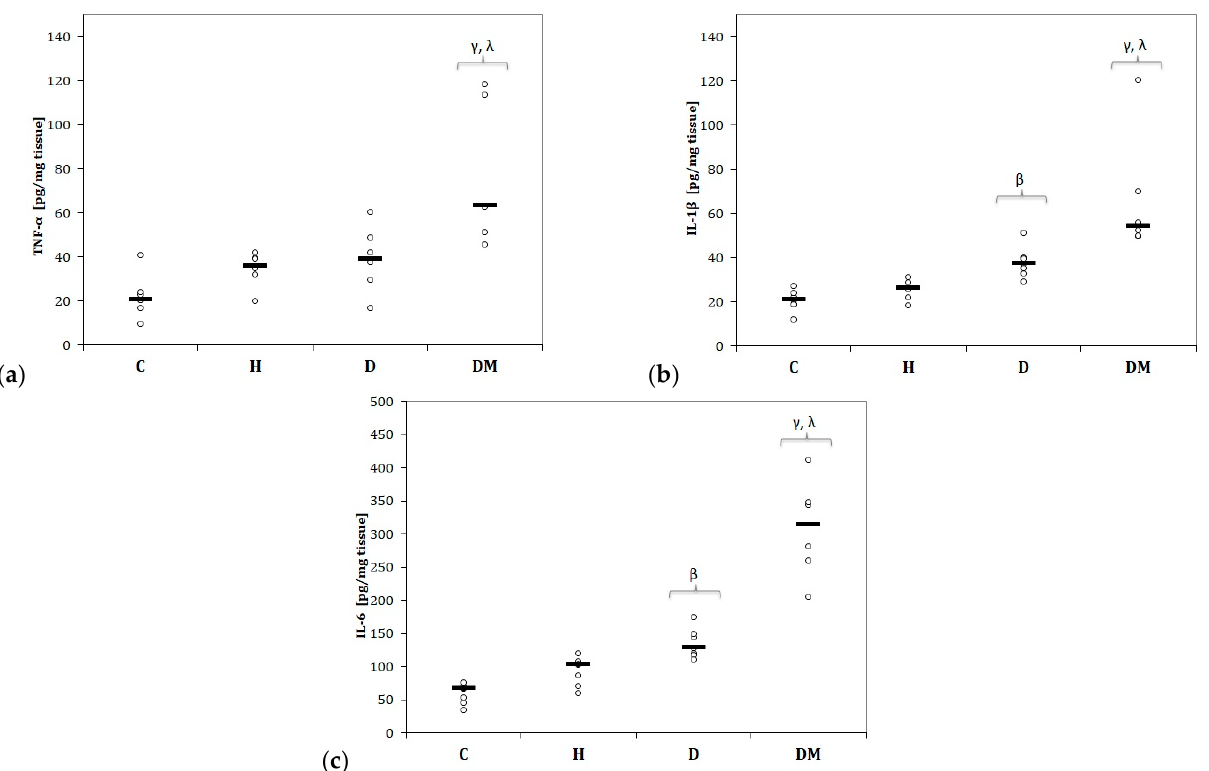
Figure 6. Variation of pro-inflammatory cytokines by groups of: ( a ) Tumour necrosis factor- α (TNF- α ); ( b ) Interleukin 1 β (IL-1 β ); ( c ) Interleukin 6 (IL-6). C = Control group, H = Hypertension group, D = Dyslipidemia group, DM = Type 1 Diabetes Mellitus group. Tumour necrosis factor- α (TNF- α ), interleukin (IL)-1, and IL-6. The letter codes correspond to the Kruskal–Wallis post-hoc p -values: < 0.025, β D compared to C, < 0.001, γ DM compared to C, < 0.048 λ DM compared to H.